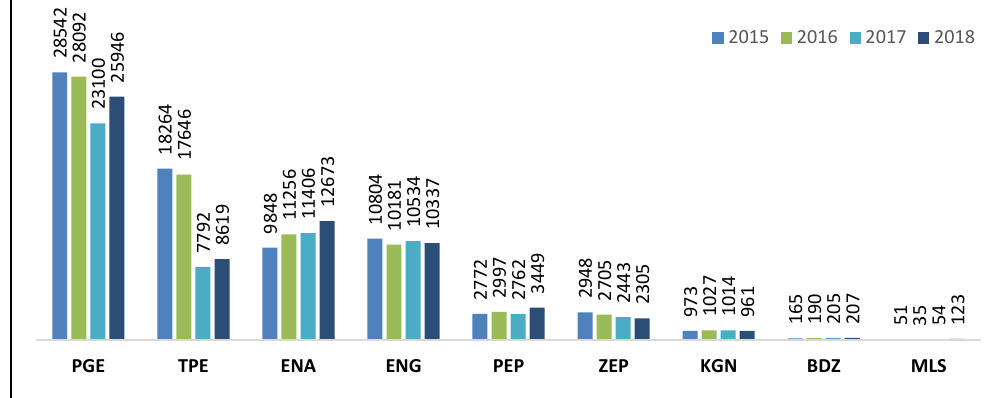
Figure 3. Sampled companies according to volume of assets (in mln of PLN).